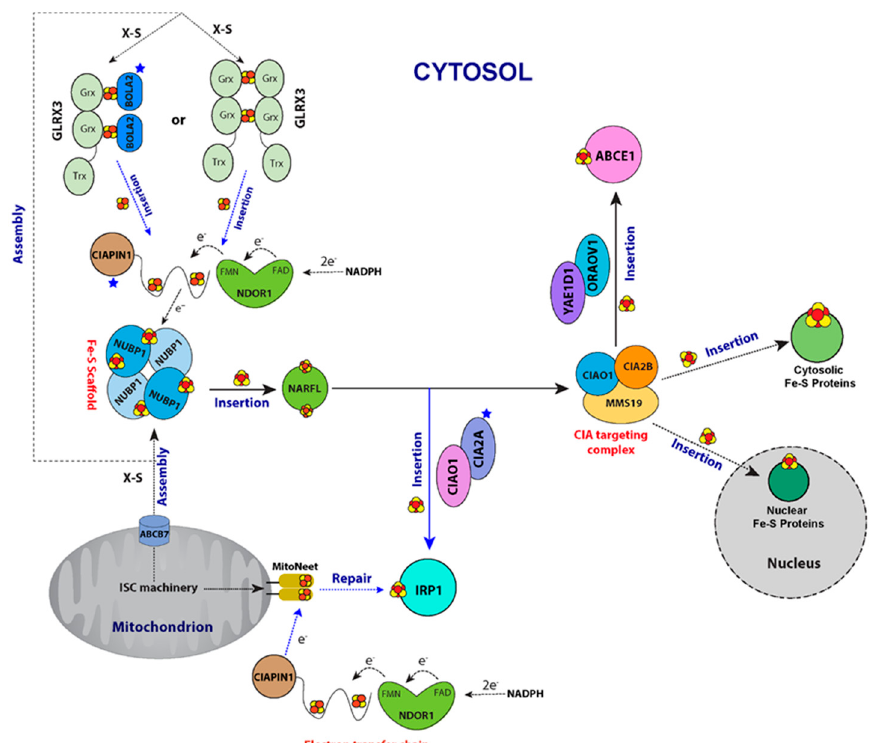
Figure 9. Schematic representation of the current model of human cytosolic Fe-S cluster assembly (CIA machinery). The CIA machinery requires the mitochondrial ISC assembly machinery, which synthesizes an unidentified sulfur-compound (X-S) that is exported from mitochondria by ABCB7. The X-S compound might be used to assemble [4Fe-4S] clusters on the (NUBP1-NUBP2) 2 heterodimeric complex and assembly of [2Fe-2S] clusters on GLRX3 and GLRX3-BOLA2. The electrons needed for [4Fe-4S] clusters assembly on the (NUBP1-NUBP2) 2 are provided by the electron transfer chain composed of NADPH, NDOR1, and anamorsin. [2Fe-2S]-(GLRX3) 2 homodimer or the [2Fe-2S] 2 -GLRX3-BOLA2 2 heterotrimer are capable of transfer Fe-S cluster to anamorsin. [4Fe-4S] clusters on (NUBP1-NUBP2) 2 are subsequently transferred to the intermediate carrier NARFL, which transfers them into cytosolic and nuclear [4Fe-4S] target proteins. The latter process is assisted by the CIA targeting complex CIAO1-CIA2B-MMS19. Other late-acting factors may be required for the maturation of certain cytosolic Fe-S proteins. The YAE1D1-ORAOV1 complex is required for the maturation of ABCE1, and the CIA2A-CIAO1 complex is required for the maturation of cytosolic aconitase IRP1. MitoNEET has been shown to be capable of repairing an Fe-S cluster on IRP1 damaged under oxidative stress conditions. NDOR1-anamorsin complex is capable of reducing the Fe-S cluster on mitoNEET to its dormant [2Fe-2S] + state. The maturation of mitoNEET is shown to be dependent on mitochondrial ISC machinery. The blue stars denote the proteins (or the protein homologs) for which the structures were obtained by NMR, and blue arrows denote the processes that were clarified by NMR.